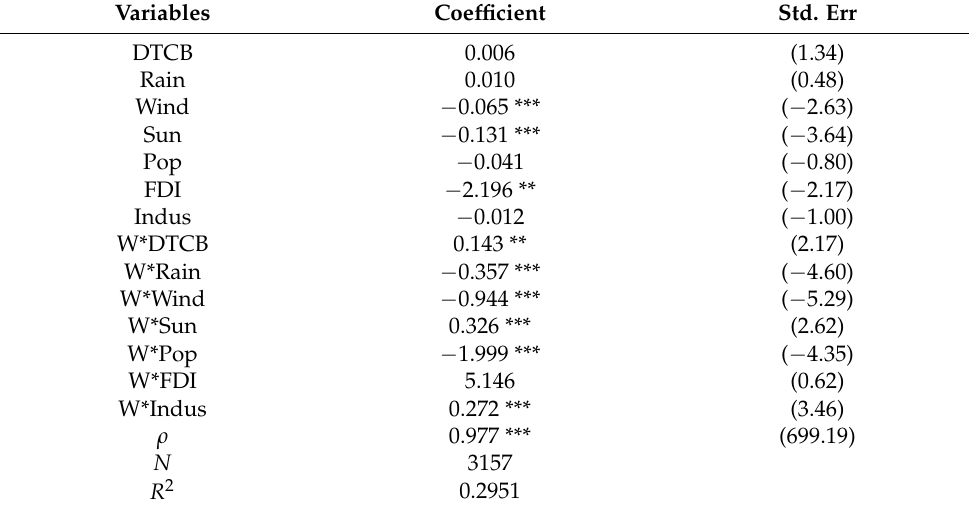
Table 4. Result of spatial Durbin